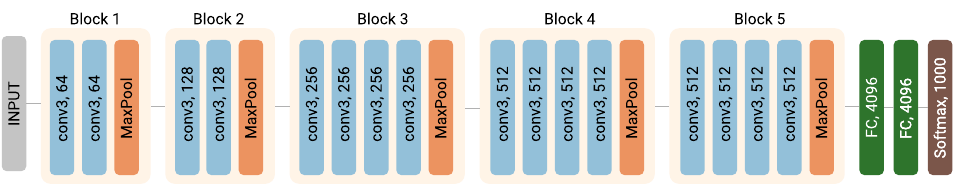
Figure 2. VGG19 network architecture. Input to the VGG19 network is 224 × 224 RGB image. Convolutional layers are labeled as “conv s , n ”, where s denotes the filter size and n number of filters in a given layer. All layers, besides the last Softmax layer, use the ReLU activation function. MaxPooling is applied on 2 × 2 patches with a stride of 2. The feature maps produced by the max-pooling layer in Block 5 are flattened into a single 25088-dimensional vector and fed into fully connected layers.